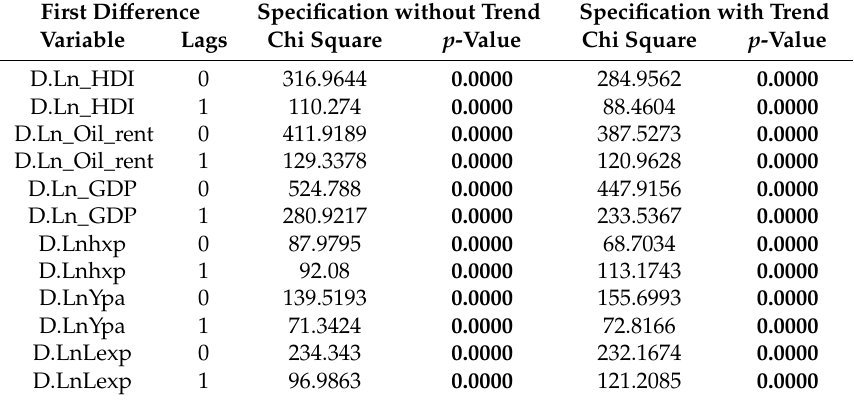
Table 9. Maddala and Wu, (1999) ADF unit roots test results at first di ff erence.